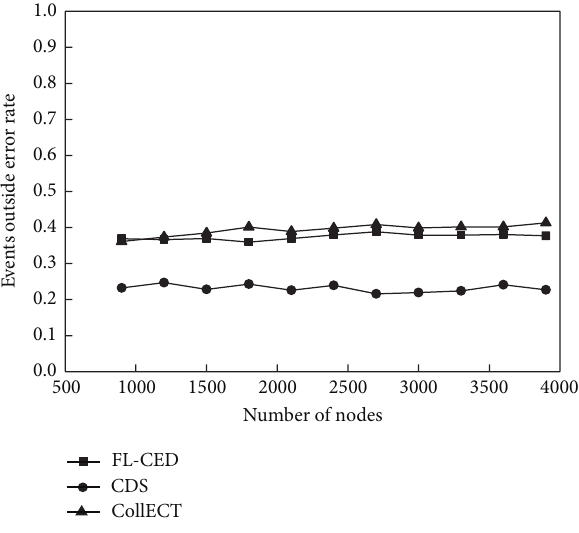
Figure 11: Events outside the error rate.